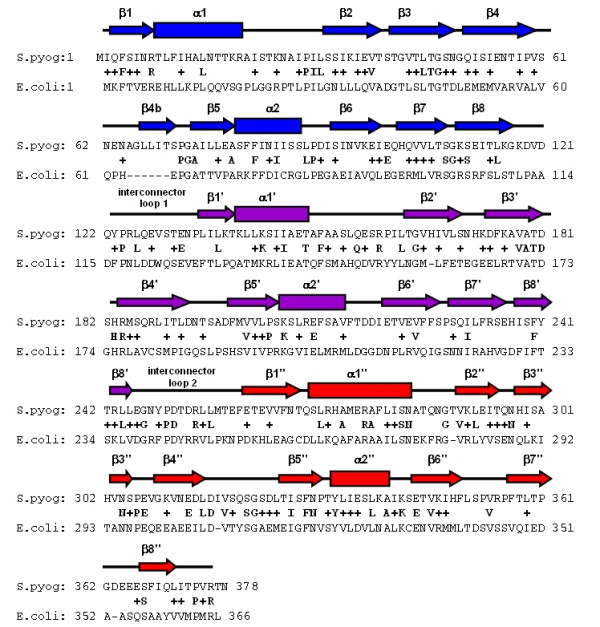
Alignment of the sequences of the Streptococcus pyogenes and E. coli β subunits as done by BLAST . Secondary structure elements are labeled using the nomenclature first used for E. coli β in ref. [10]. An additional β-strand found only in domain I of the S. pyogenes clamp from residues 67–71 is labeled as β4b.